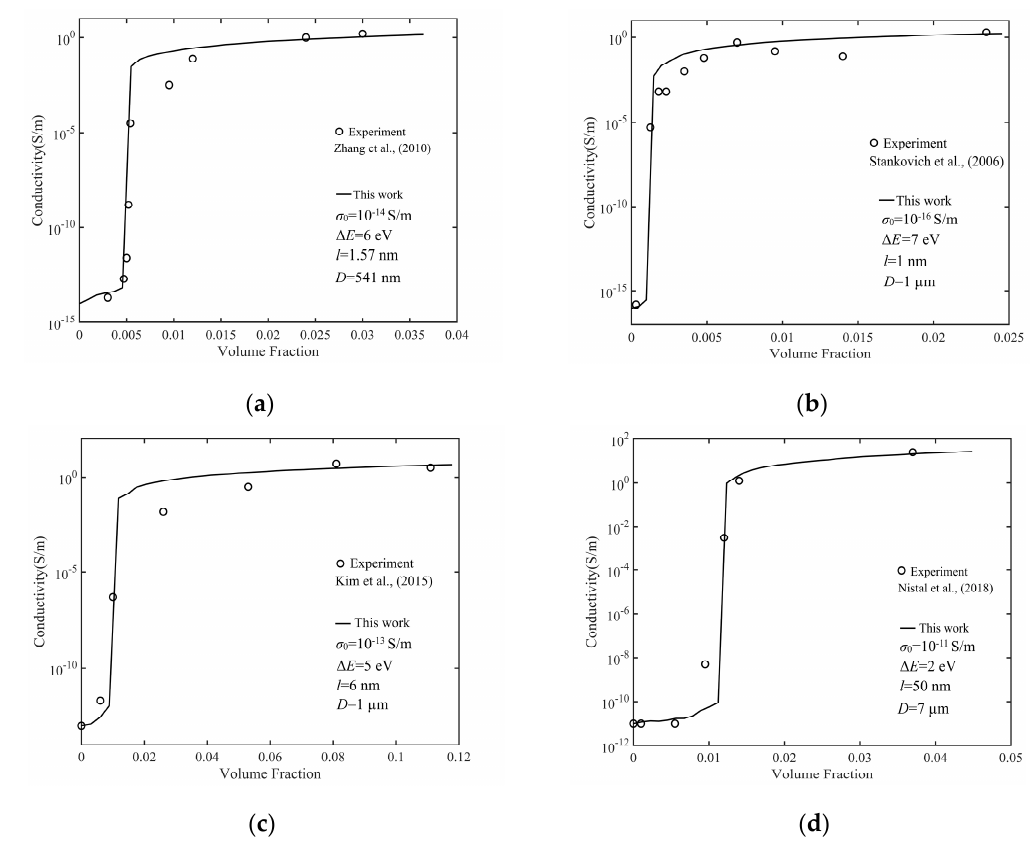
Figure 5. Numerical simulation results and experimental data of conductivity: ( a ) with Zhang et al. [46], ( b ) with Stankovich et al. [18], ( c ) with Kim et al. [47], and ( d ) with Nistal et al. [19].